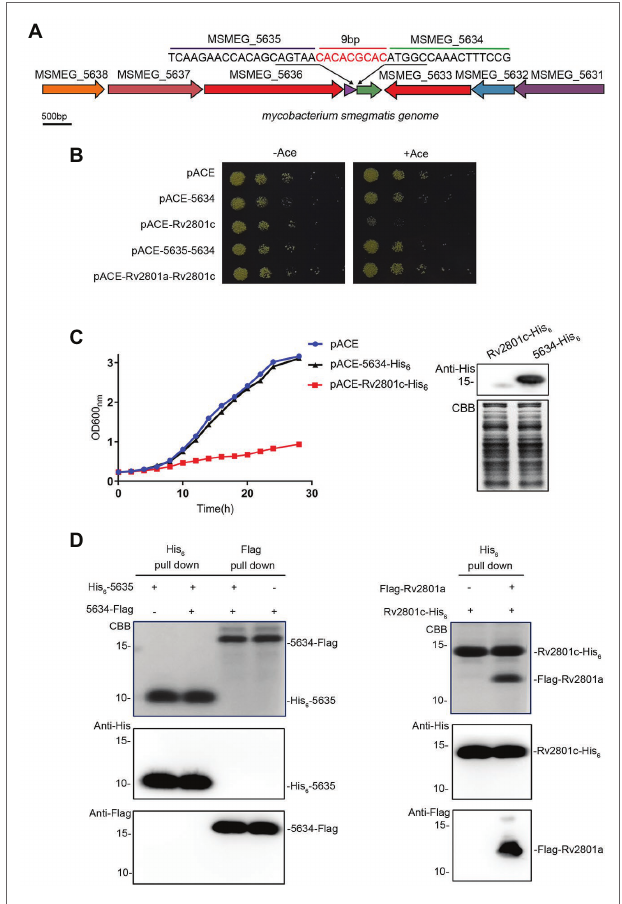
FIGURE 1 | MSMEG_5634 is not a toxin protein in the toxin-antitoxin system. (A) MSMEG_5634 gene locus in the Mycobacterium